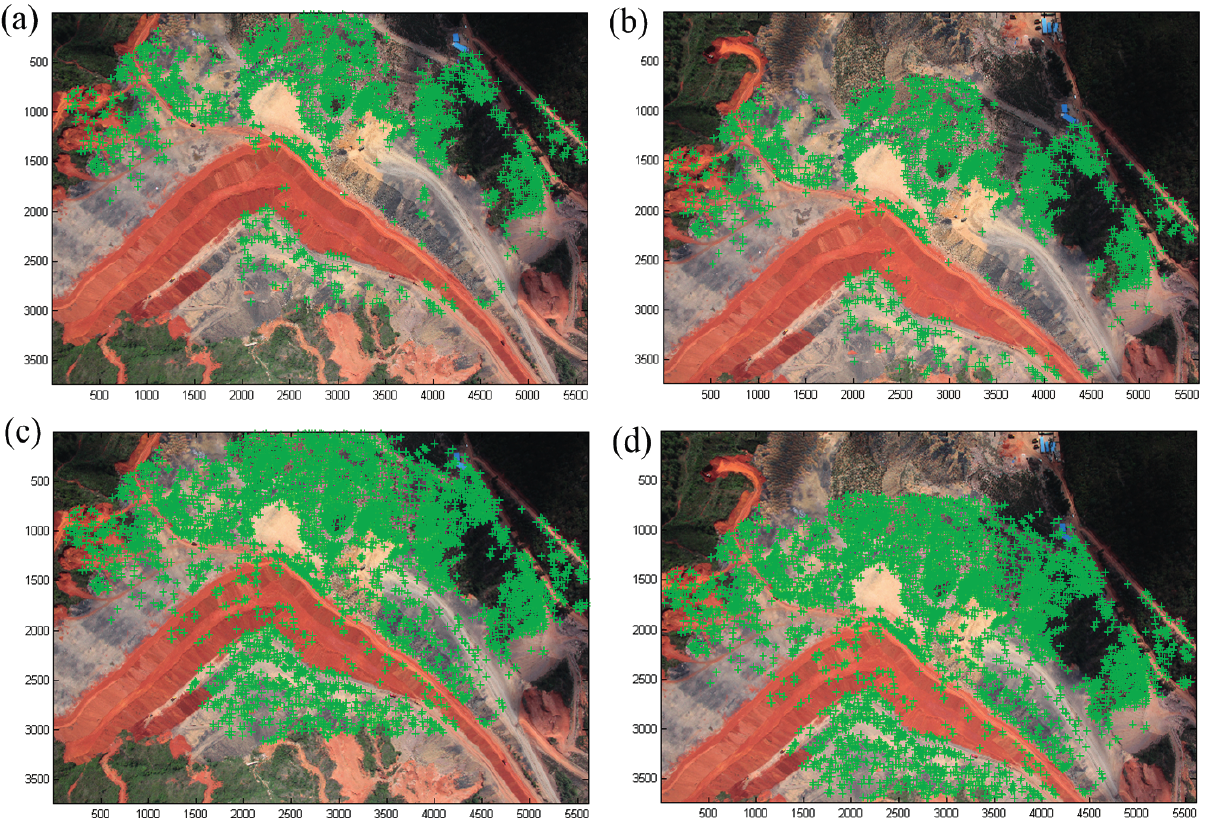
Figure 5. Result of the matched points between two UAV images in the Jianshan area (Unit: pixel). ( a , b ) matched points by the use of SIFT operator (2901 matched point pairs from a total of 57,243 point pairs with a threshold of 0.3 pixels); ( c , d ) dense matched points based on the method of the optimal exterior orientation parameters (5517 matched point pairs with a searching size of 21 pixels, correlation size of 7 pixels and least squares size of 21